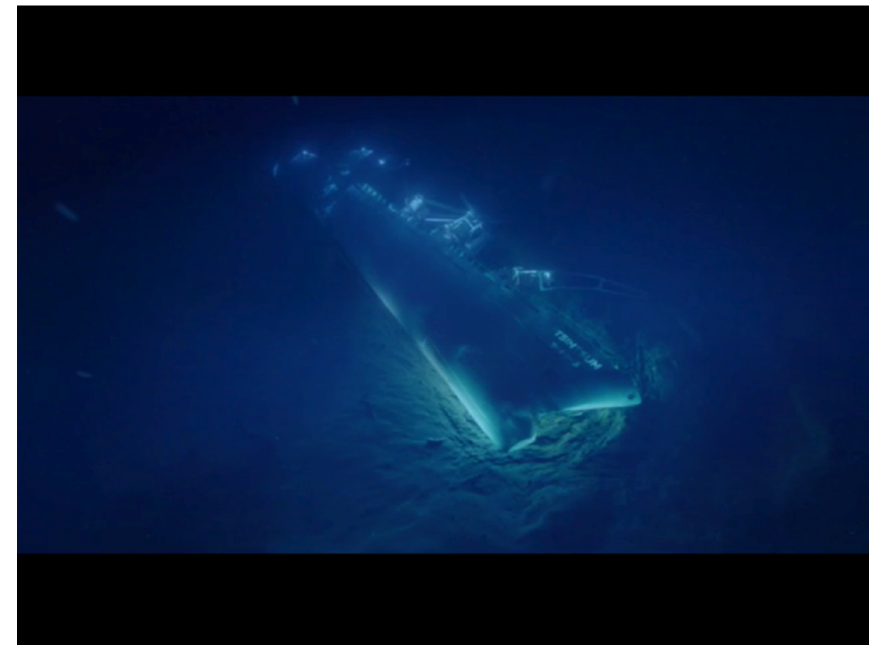
Figure 15. The Tsimtsum rests on the bottom of the ocean.